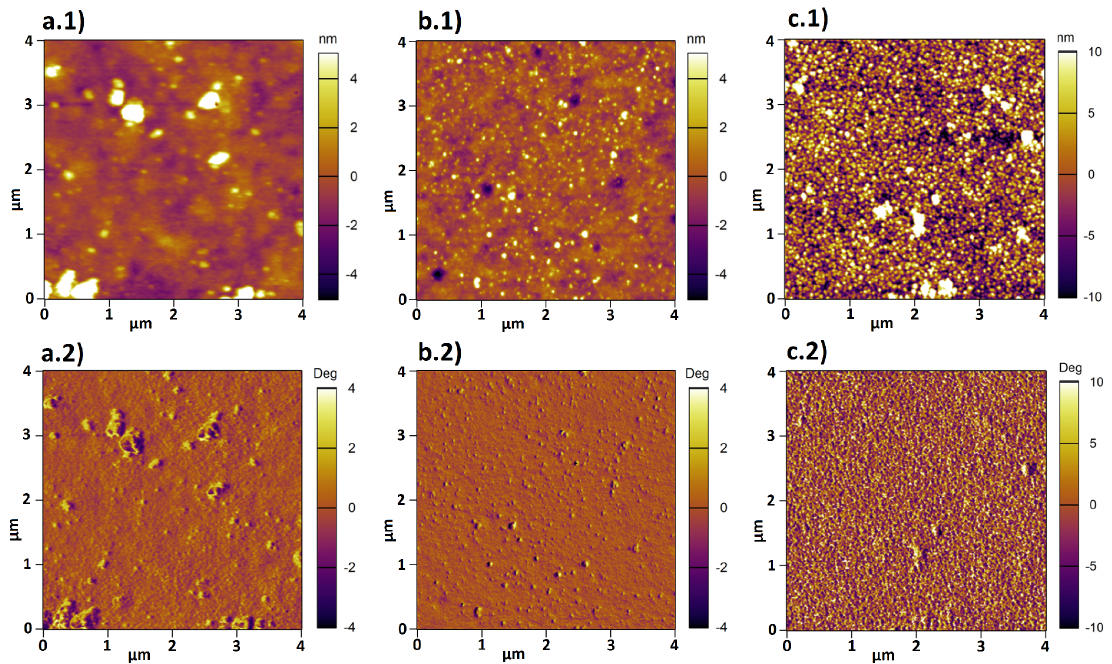
Figure 6. Height ( a.1 - c.1 ) and phase ( a.2 - c.2 ) images were recorded in water by AFM for composites ( a.1 / a.2 ) at pH 4, ( b.1 / b.2 ) at pH 6, ( c.1 / c.2 ) at pH